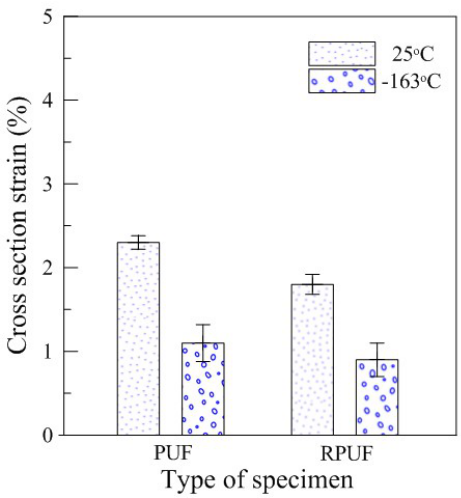
Figure 8. Cross-sectional strain of the rigid PUF after the restraint compressive test. Table 5. Average cross-section of the rigid PUF specimen after the restraint test. Material Pure PUF